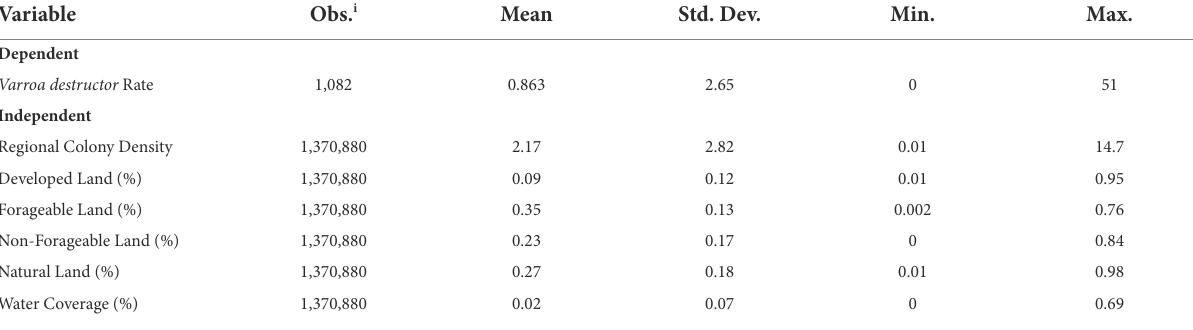
TABLE 2 Descriptive statistics of the dependent and independent variables used.